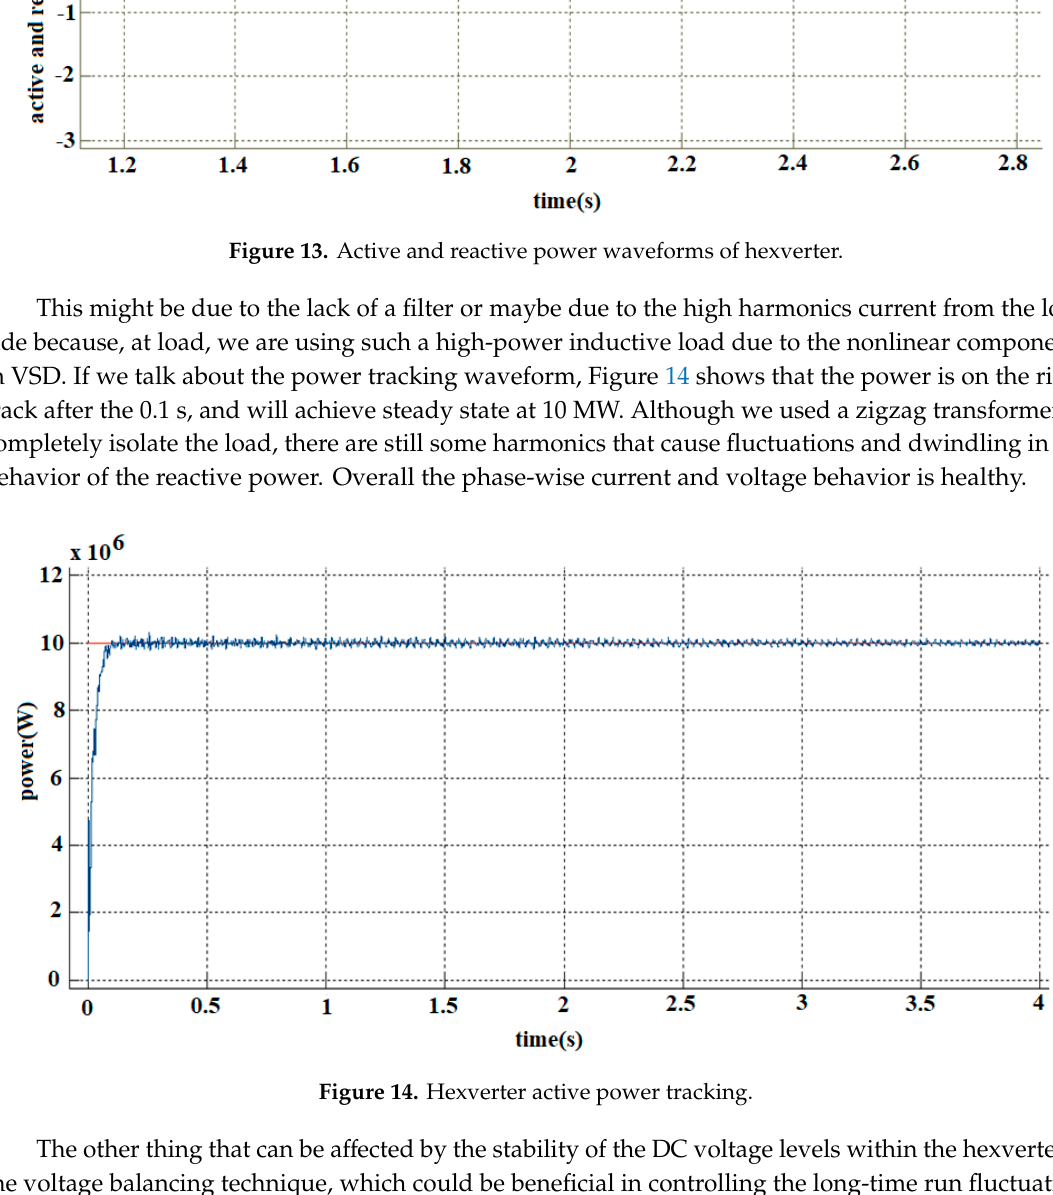
Figure 15. Input-side current tracking of d axis.